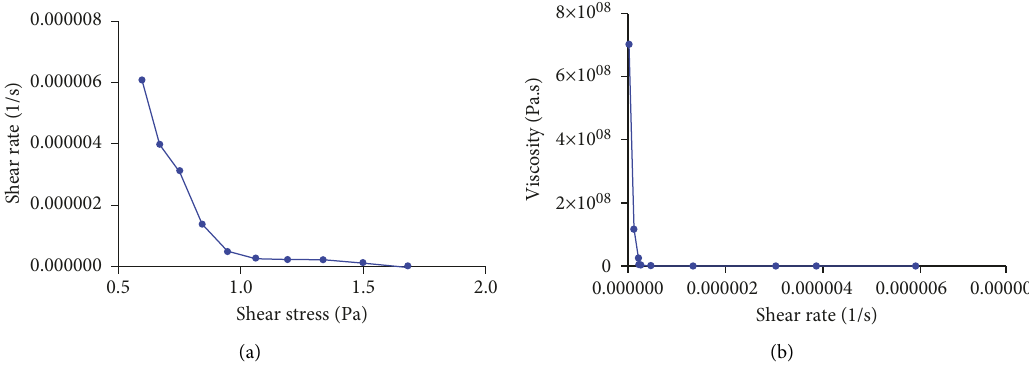
Figure 4: Relation between (a) shear stress and the shear rate (b) the shear rate and viscosity.